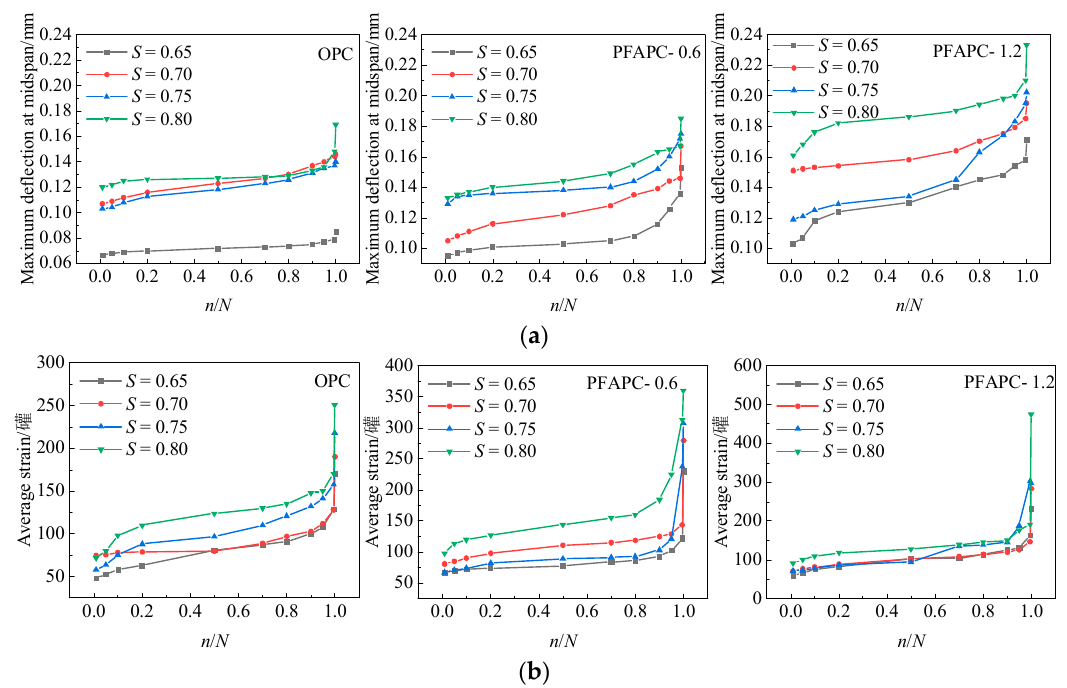
Figure 4. Curves of specimen deformation with cyclic ratio: ( a ) maximum deflection at midspan; ( b ) average strain.